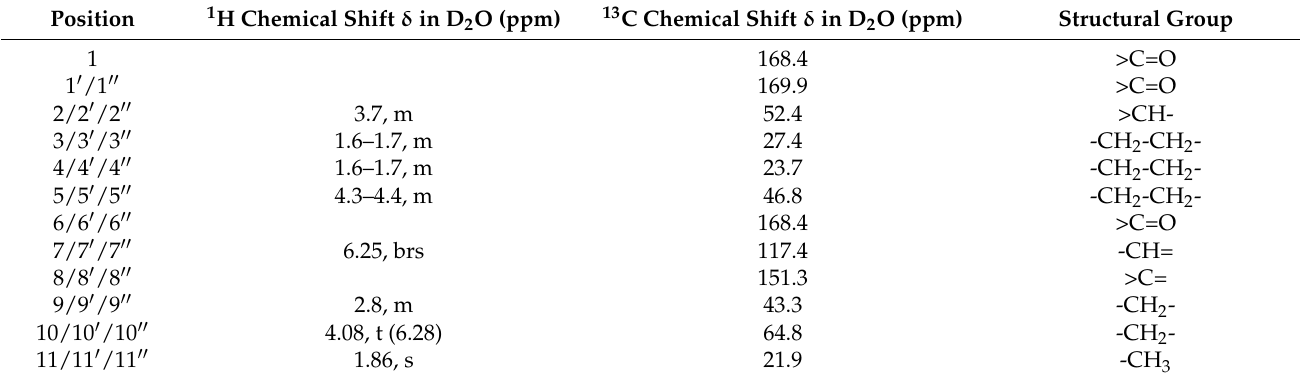
Table 1. 1 H-NMR (500 MHz) and 13 C NMR (125 MHz) chemical shifts of coprogen B in D 2 O. Position